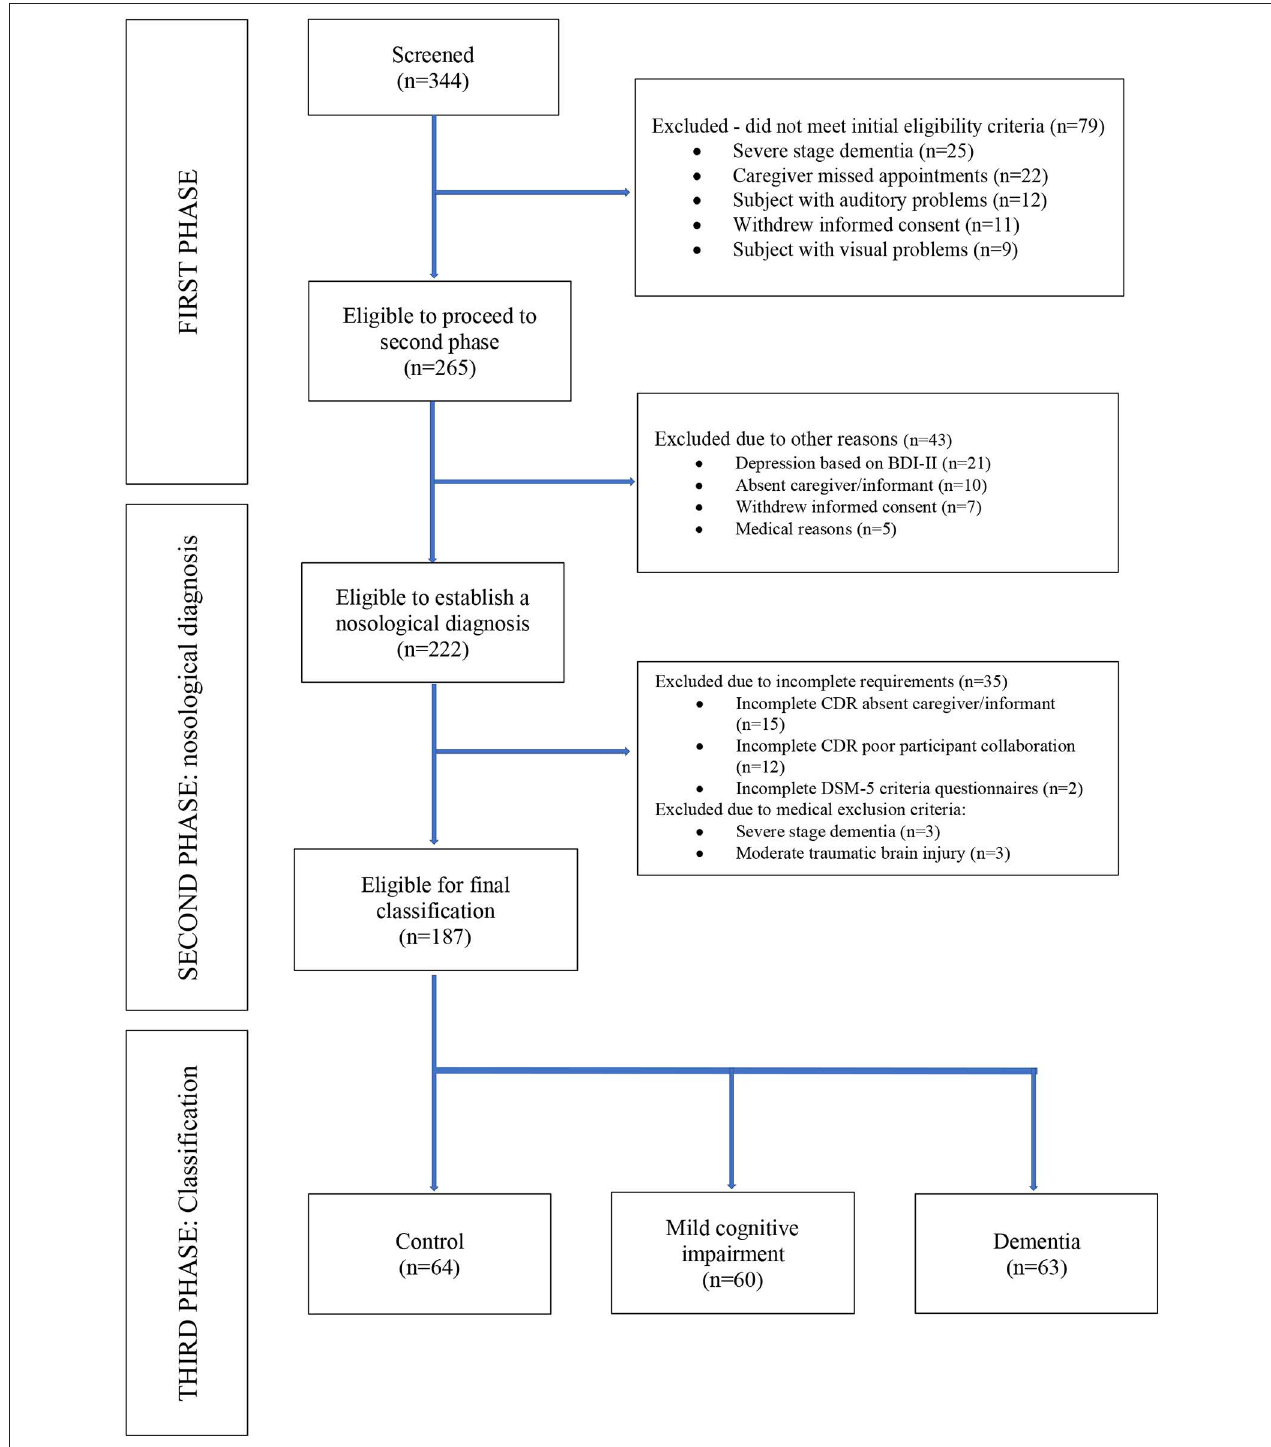
FIGURE 1 | Study flow diagram. Centros de Salud de Ventanilla, Callao, Lima. 2018-2019.